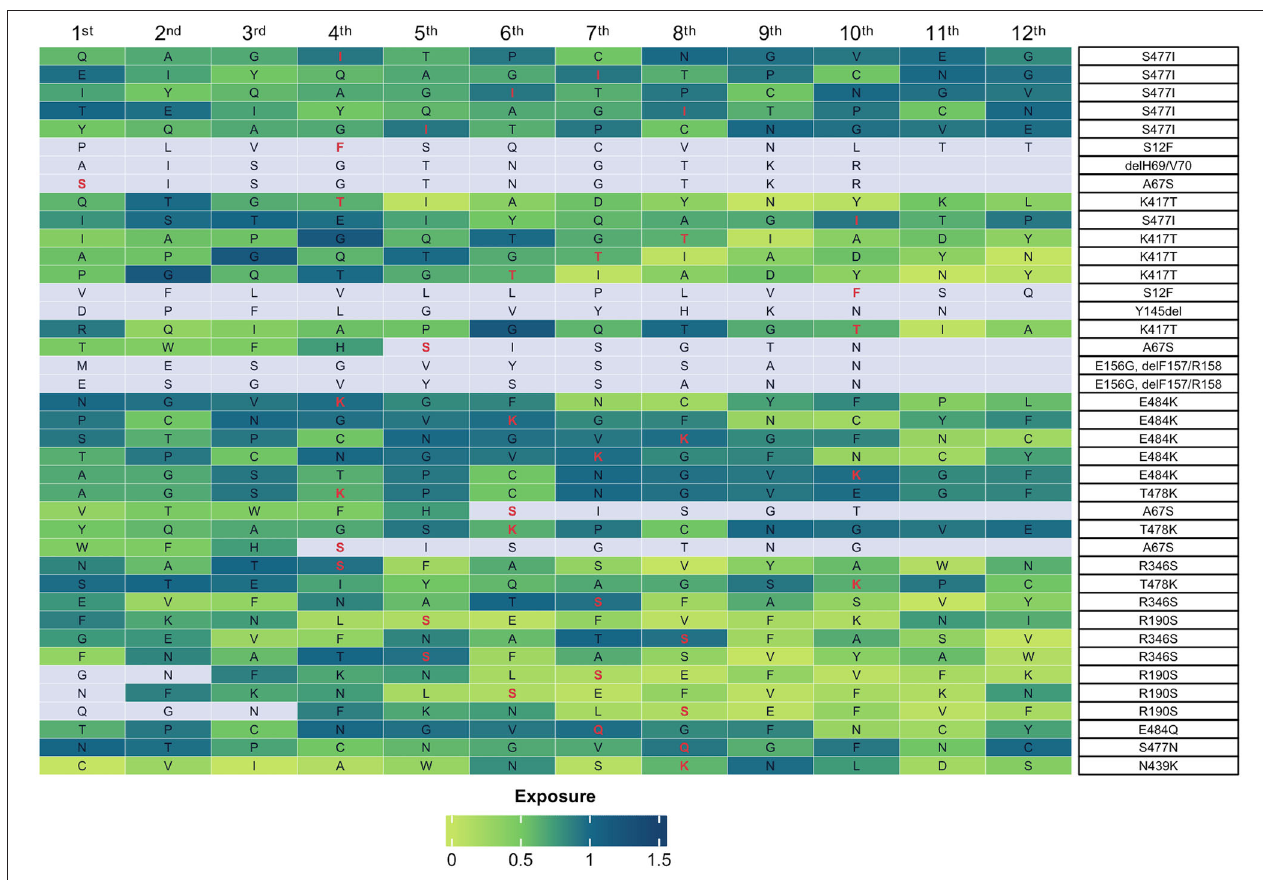
FIGURE 10 | Accessibility of mutant peptides on surface of the S protein. The heatmap shows the accessibility scores of peptides containing the residues indicated on the right. Boxes represent the amino acid residue under analysis. The mutations present in the sub-genotypes identified in this study are highlighted in red. The accessibility score is indicated by the shades of green on the scale from 0 (light green, no exposure) to 1.5 (dark green, high exposure). The color gray indicates that no exposure score is